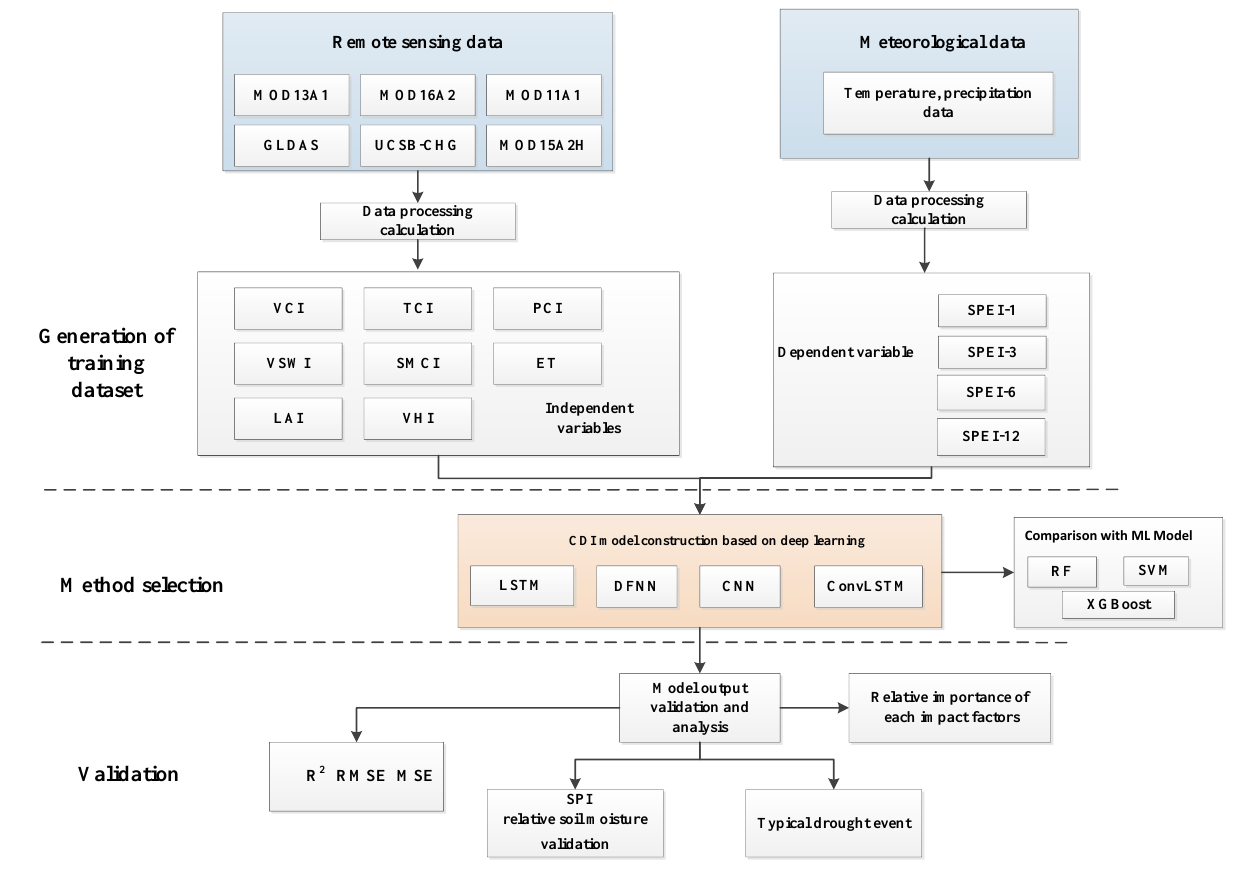
Figure 3. Flowchart of the drought monitoring model construction.